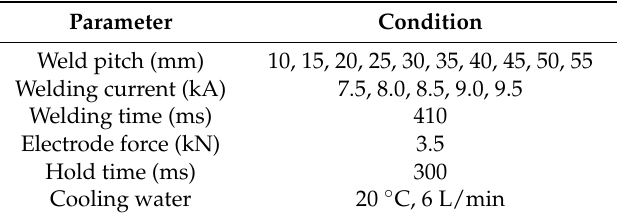
Table 2. Experimental welding